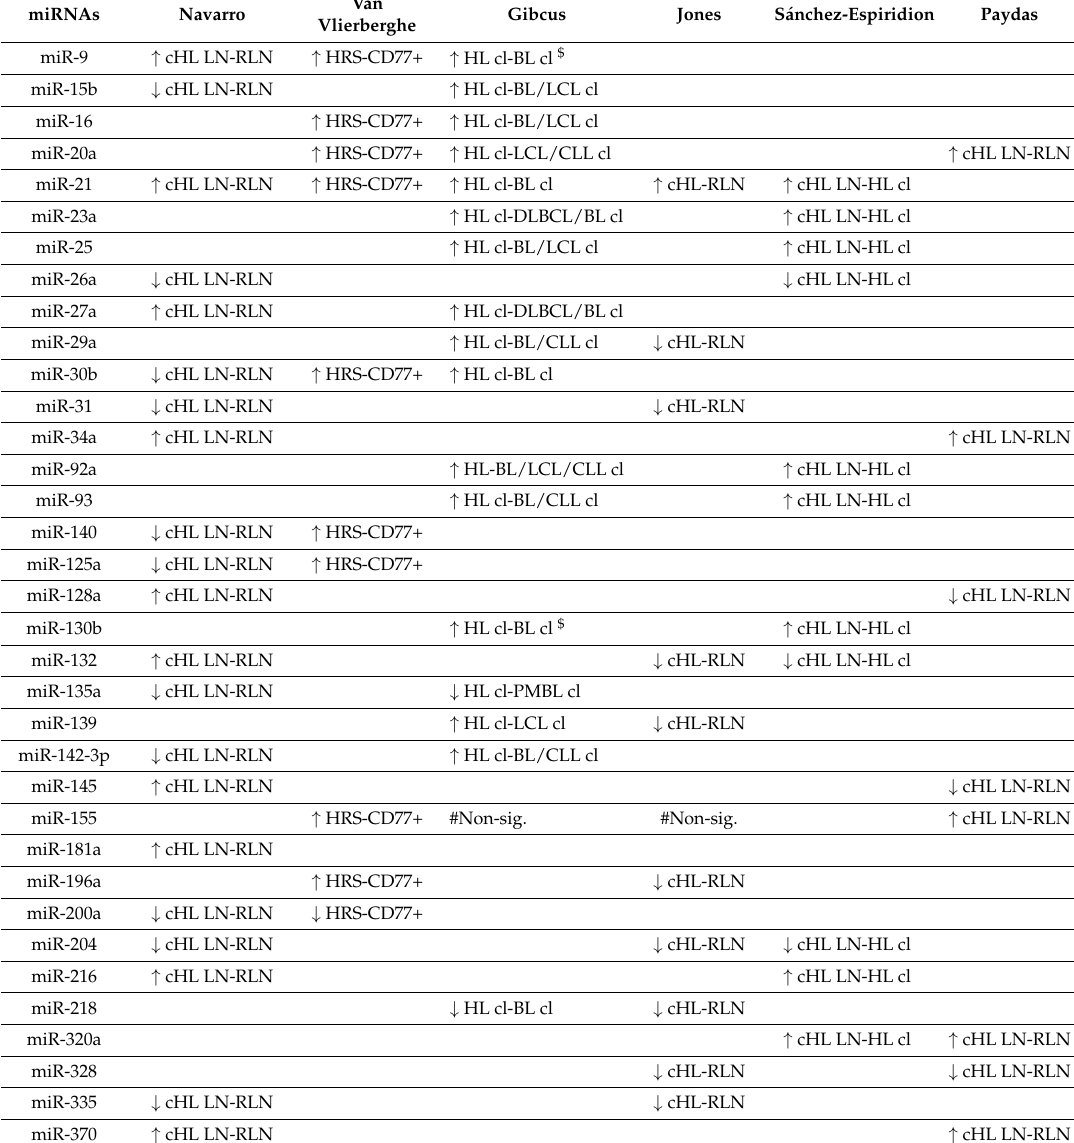
Table 1. List of microRNAs present in at least two of the six miRNA signatures. Up and down arrows indicate if the miRNA is overexpressed or underexpressed in HL vs the compared group. The compared groups differ between the different studies. cHL LN: cHL lymph nodes; RLN: Reactive lymph